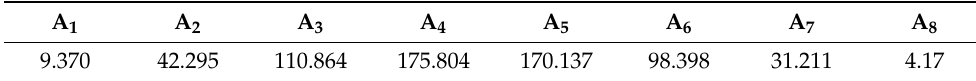
Table 8. Constants of F( α